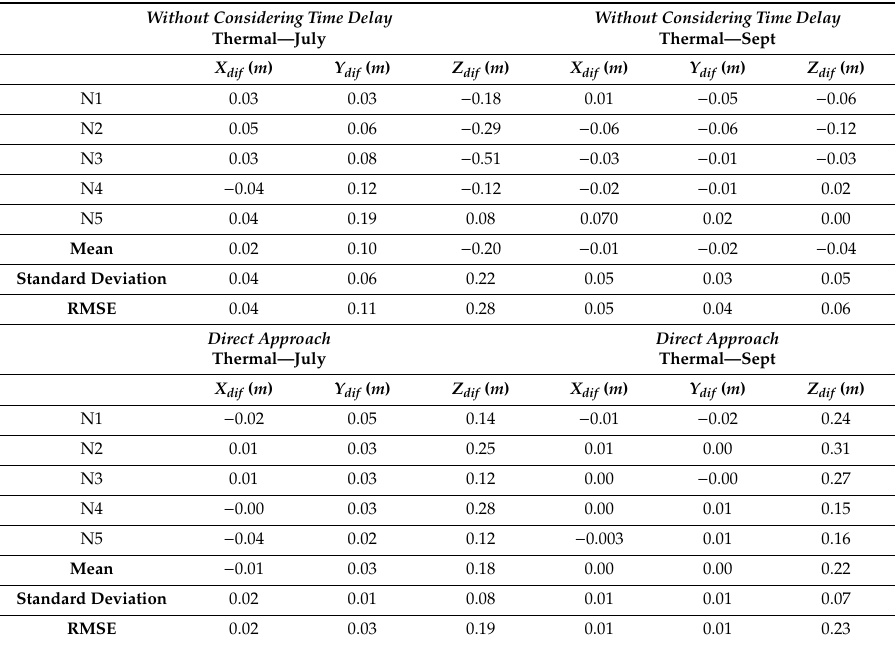
Table 7. Components and mean / standard deviation / RMSE of the di ff erences between check points and surveyed coordinates for the five check points for the DJI M200 thermal